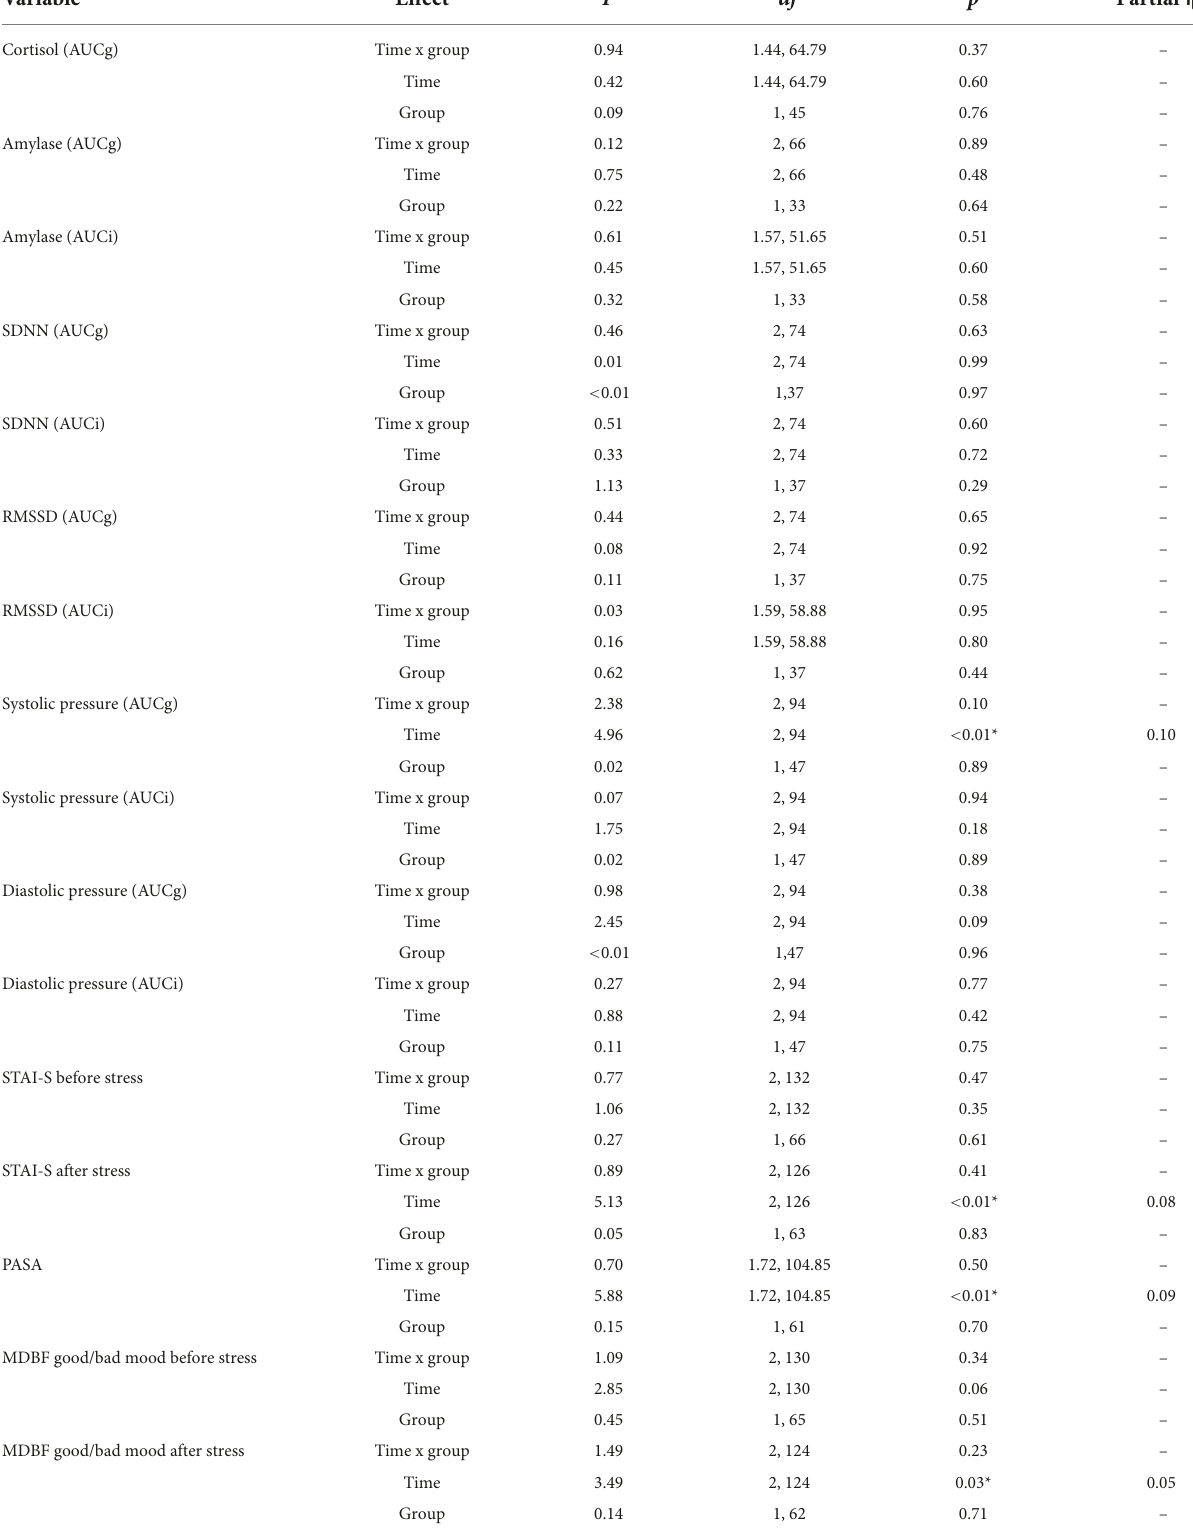
TABLE 3 Results for the group x time interaction effects (mixed ANOVA) in men across trier social stress test for groups (TSST-Gs) (t0, t1, t2).